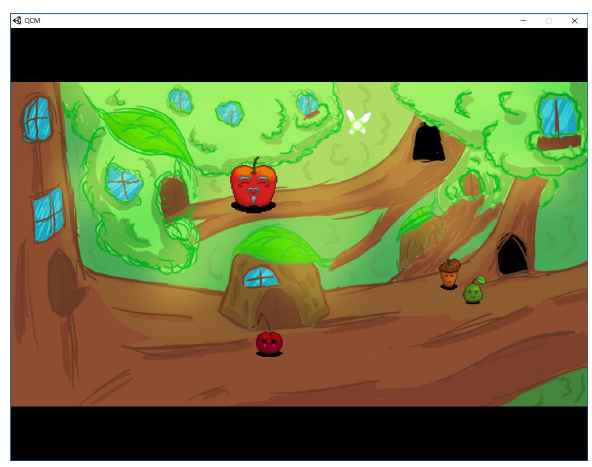
Figure 6. Narrative game: screenshot of a game session with text.